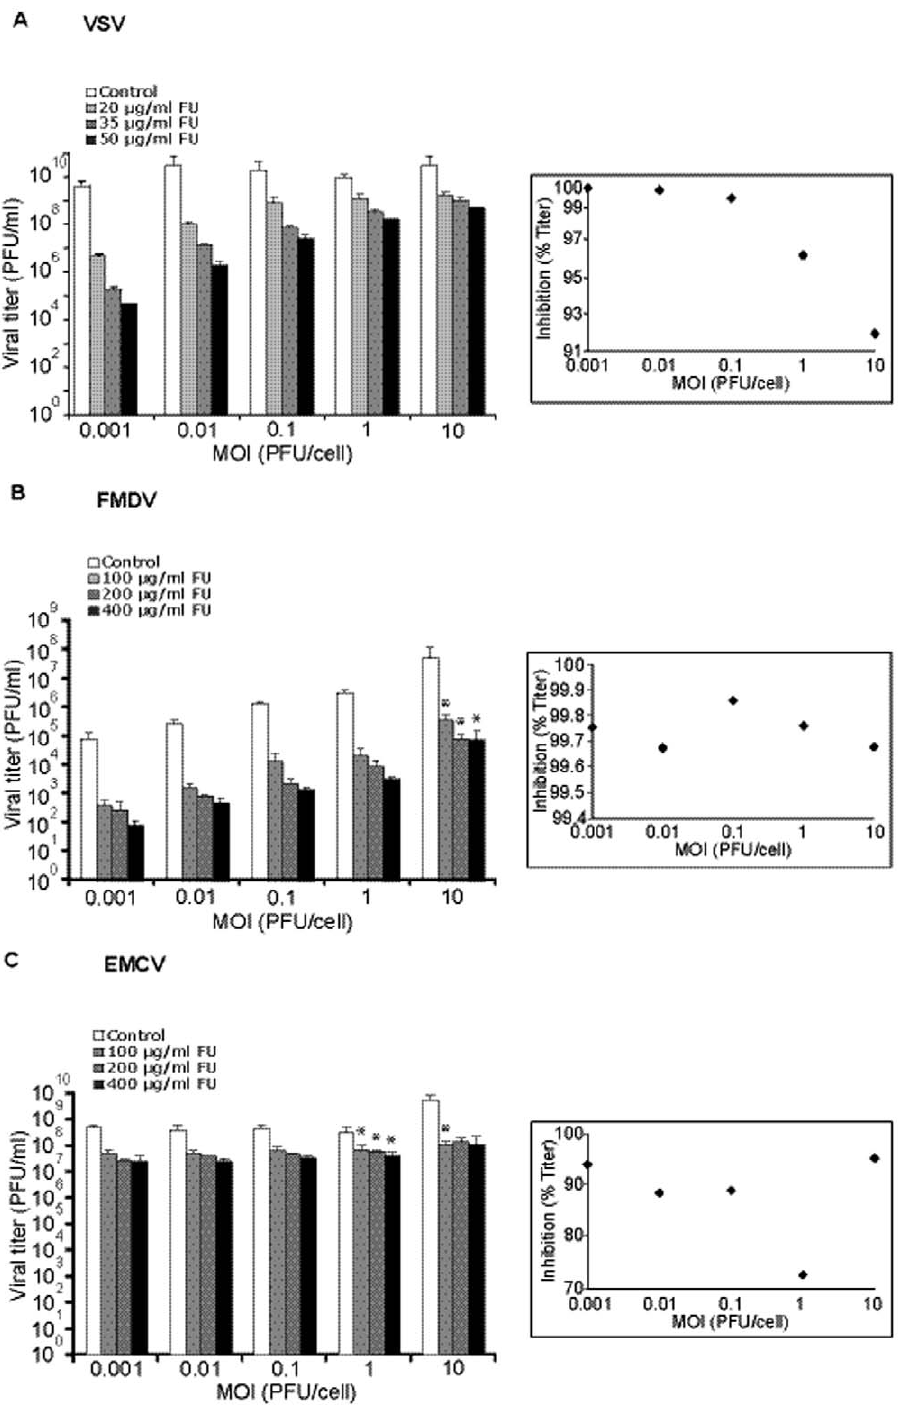
Figure 2. Effect of the multiplicity of infection (MOI) on the inhibition of vesicular stomatitis virus (VSV), foot-and-mouth disease virus (FMDV), and encephalomyocarditis virus (EMCV) by 5-fluorouracil (FU). BHK-21 cells were infected with VSV (A), FMDV (B) or EMCV (C) at the indicated MOI in the absence (white bars) or presence (increasingly dark bars) of different concentrations of FU, as indicated in each panel. Cell culture supernatants were harvested at 24 h p.i. and titrated as described in Materials and Methods. Viral titers are the average of at least four determinations and standard deviations are given. The asterisks above the bars indicate those inhibitions that are significantly different from those obtained in the infection at a MOI of 0.001 PFU/cell. No asterisks were added for VSV because all the pairwise comparisons with the inhibition at MOI 0.001 PFU/cell were significantly different. The panels on the right visualize the variation of the percentage of inhibition (by 35 m g/ml FU for VSV, 200 m g/ml FU for FMDV and EMCV) as a function of the MOI.